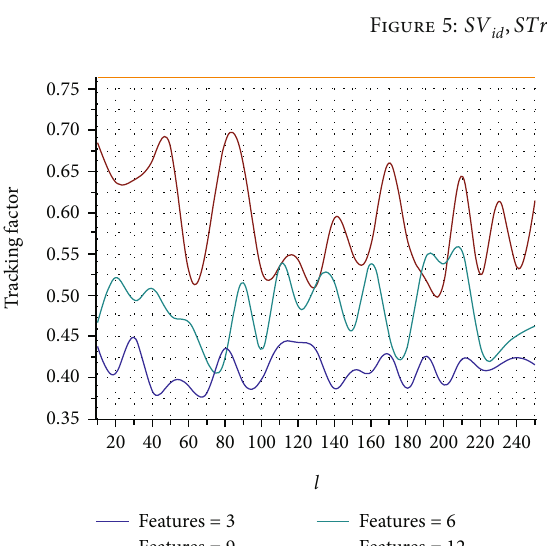
for the varying L f